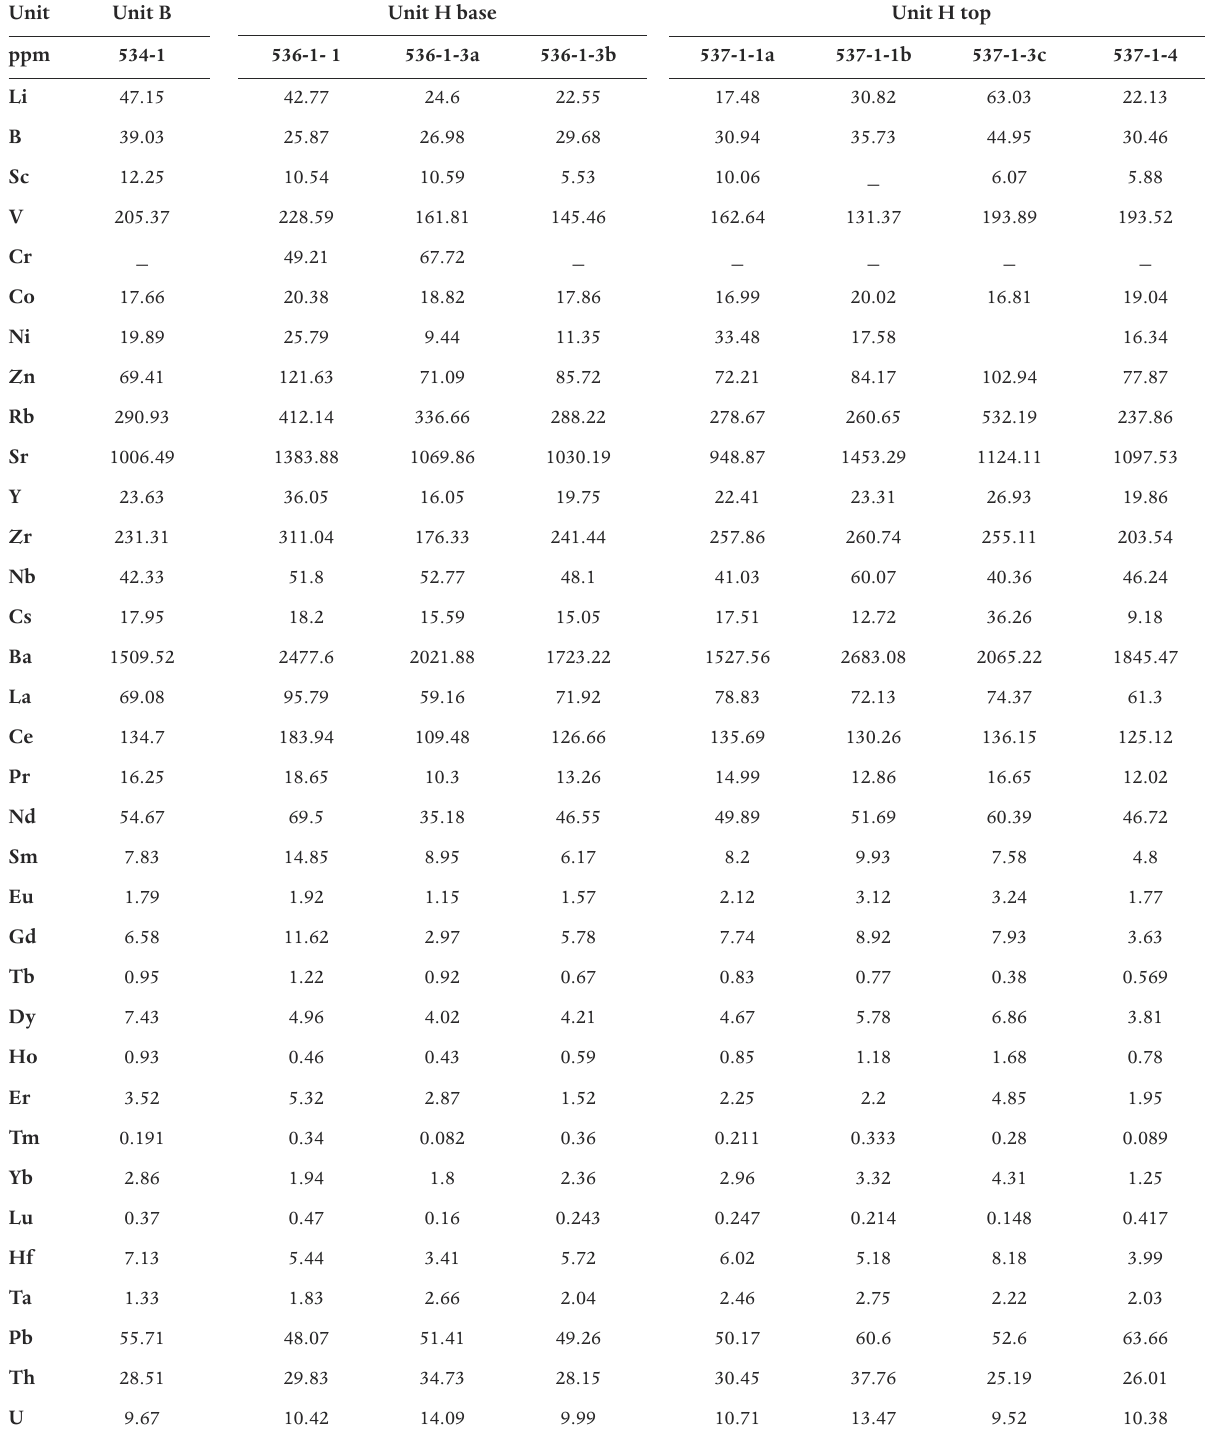
Table 3. Selected compositions of trace elements in melt inclusions by